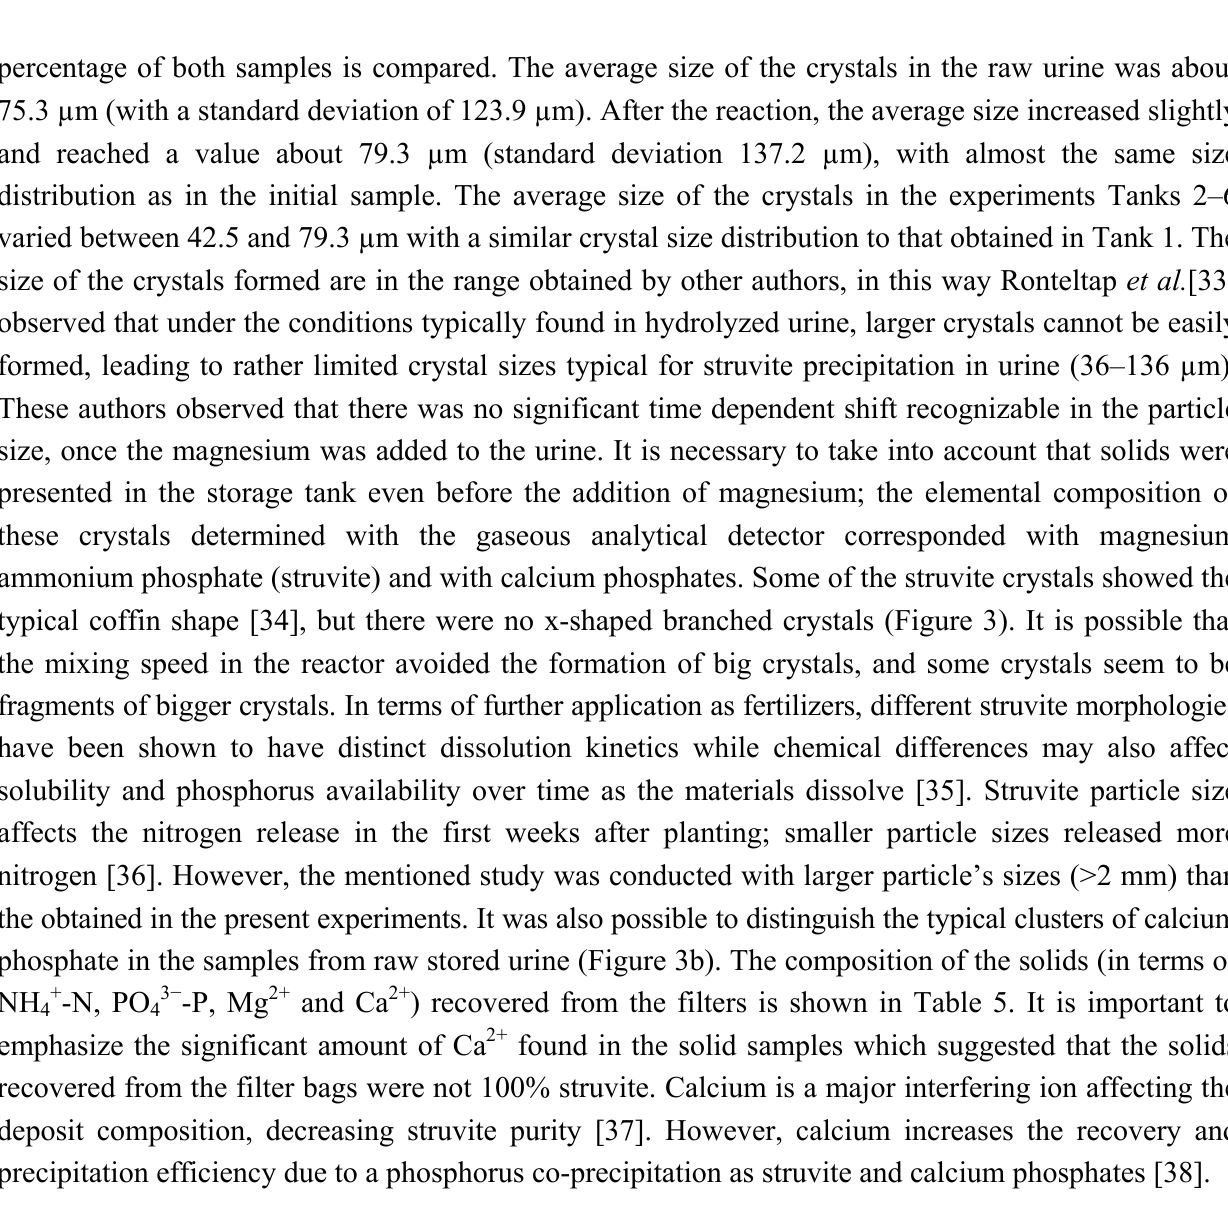
Table 5. Composition of solids in mg of compound per gram of solid. Excess of PO 43 − and Ca 2+ consumed and Ca